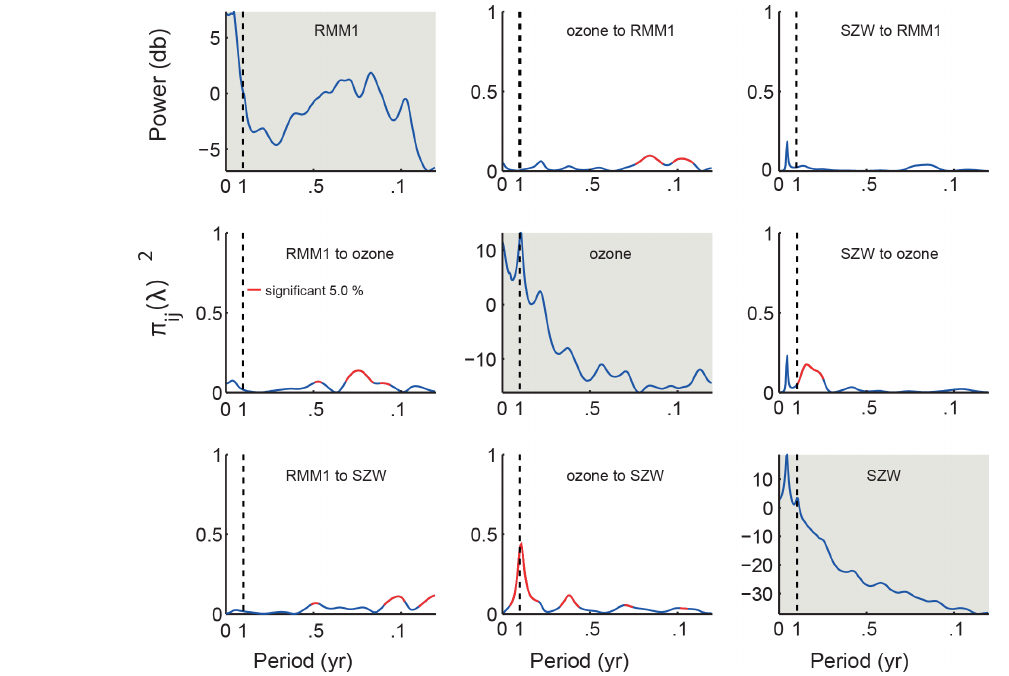
Figure 2. PDC between tropical stratospheric ozone and stratospheric zonal wind (SZW) as well as the RMM MJO index at the fast ( > 20d) timescale; frequencies are given are given in cycles per year. Panels in the main diagonal show the power spectral density of each time series. Off-diagonal panels indicate the PDC values between the time series. For each panel, the x axis represents the frequency and y axis the value of the PDC. Red lines represent the PDC values that were statistically